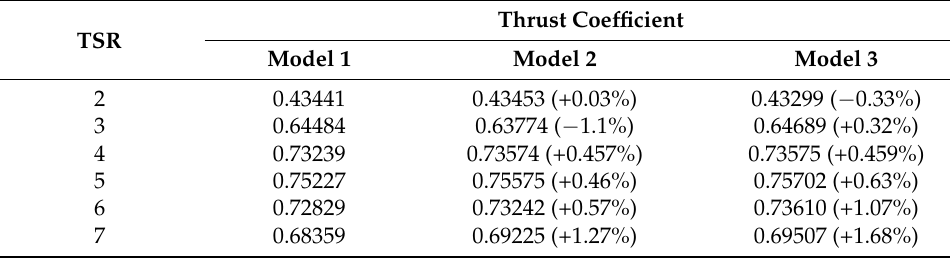
Table 7. Trust coefficients of three models under different